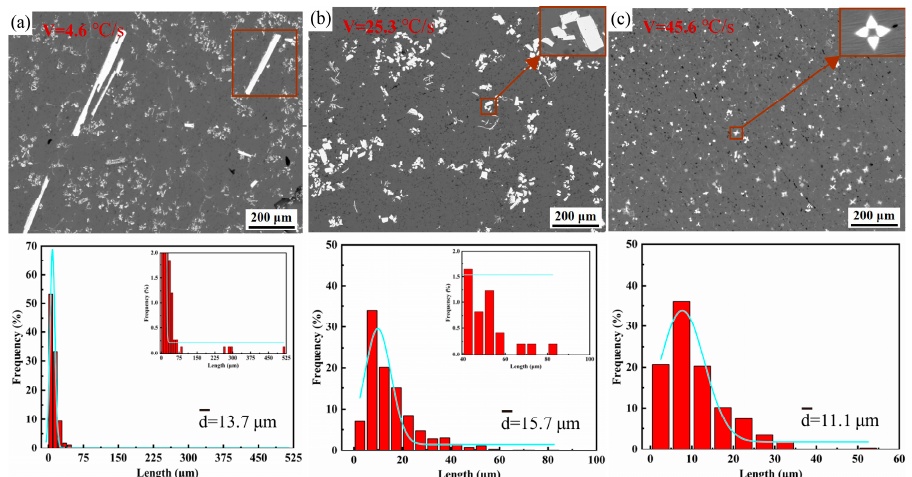
Figure 6. SEM (backscatter electron mode) images and distribution of Al 3 Zr particle lengths in the remelted Al-5Zr alloy at different cooling rate conditions with 920 ◦ C remelting temperature (the blue line is the fit curve): ( a ) low velocity; ( b ) intermediate velocity; ( c ) high velocity.